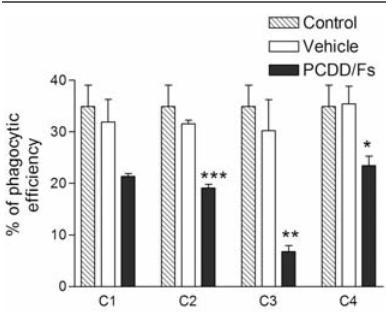
Figure 7. Effects of various concentrations of polychlorinated dibenzo -p- dioxins/dibenzofurans (PCDDs/Fs) on the phagocytic efficiency of the extruded cells of E. andrei. Asterisks represent significant difference compared with vehicle controls (* P<0.05; ** P<0.01; ***